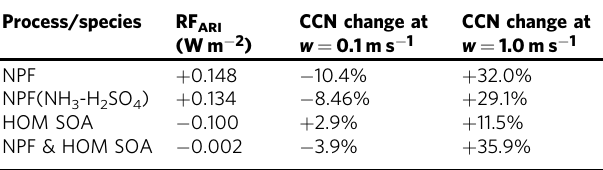
Modelled direct aerosol radiative forcing (RF ARI ) and relative change in the CCN number concentrations because of NPF, NPF formed exclusively from clustering of NH 3 and H 2 SO 4 , HOM SOA formation, and NPF and HOM SOA